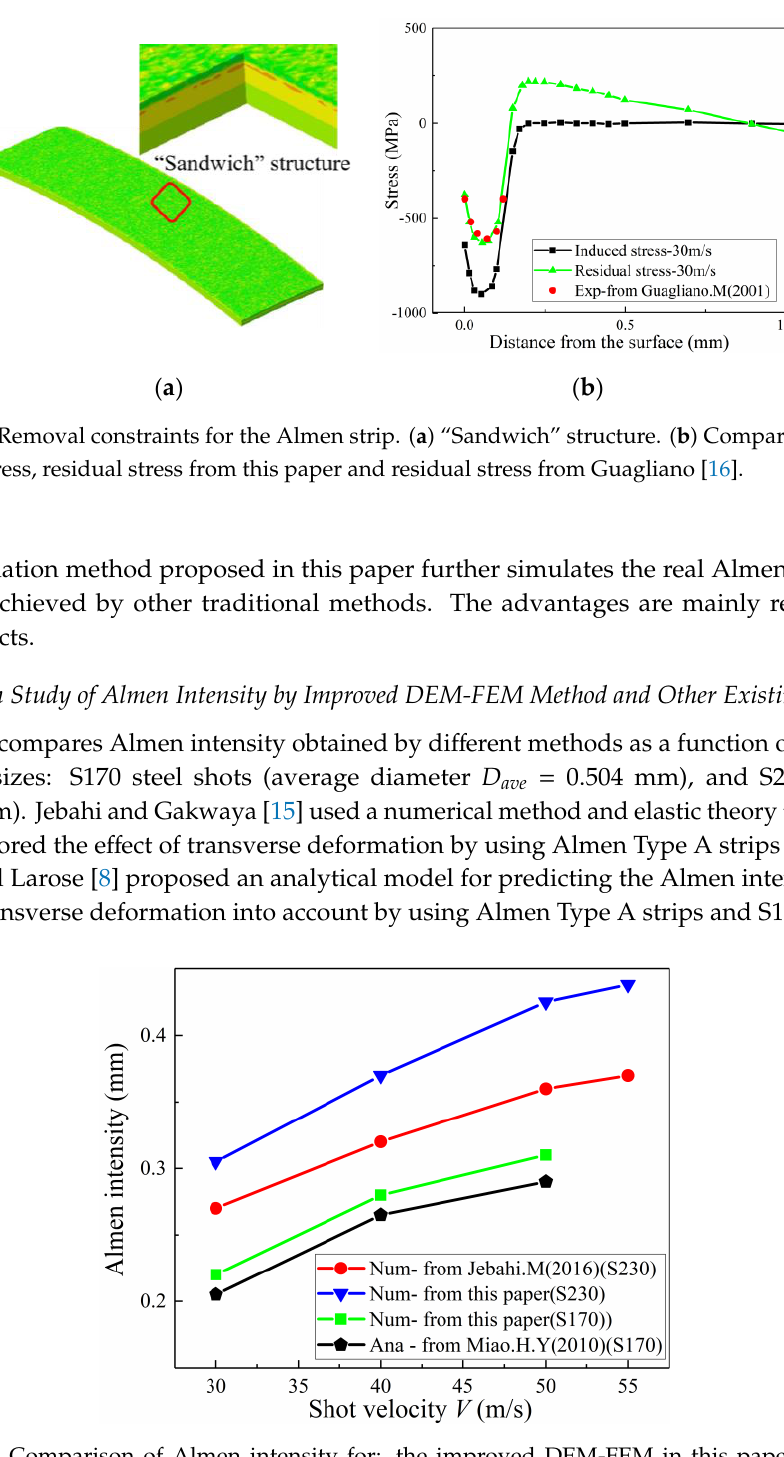
Figure 18. Comparison of Almen intensity for: the improved DEM-FEM in this paper, existing numerical method from Jebahi. M (2016), and analytical model method from Miao. H. Y (2010).